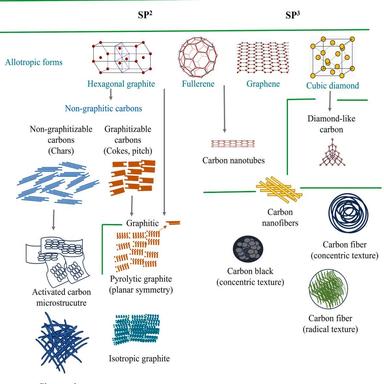
Various structures and allotropes of carbon.